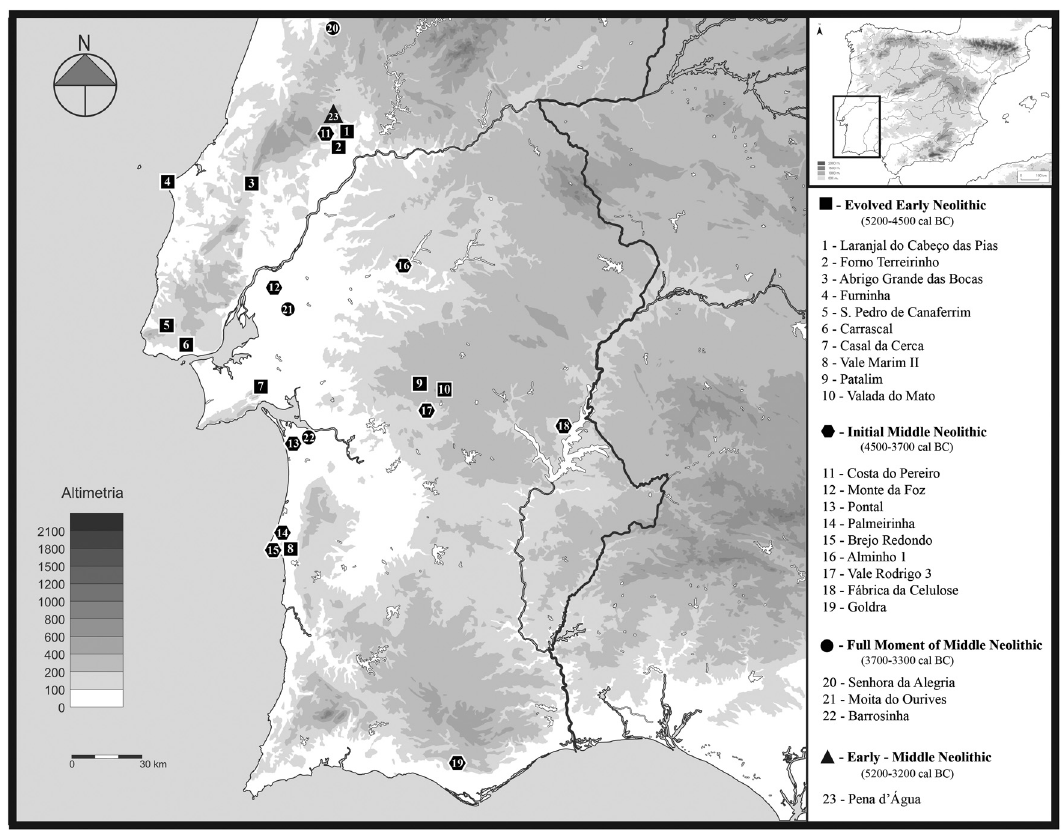
Figure 1: Archeological sites mentioned in text ( ∼ 5200 – 3300 cal BC ) ( basemap: Boaventura, 2009; Trabajos de Prehistoria for the map of Iberia )